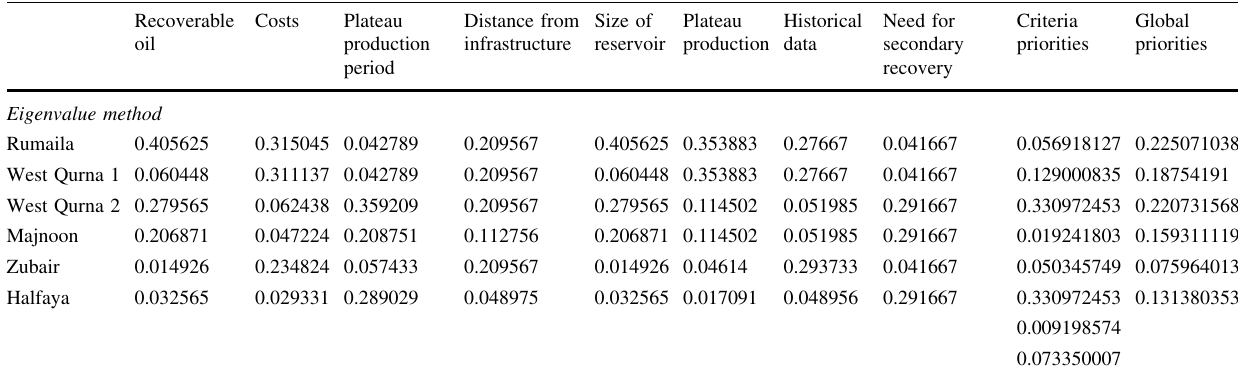
Table 5 Analytic hierarchy